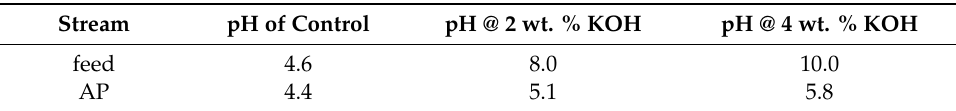
Table 2. pH values of feed and products with and without KOH. Test performed at 350 ◦ C, 5 min, and 10 wt. % biomass to water ratio (B / W). Stream pH of Control pH @ 2 wt. %